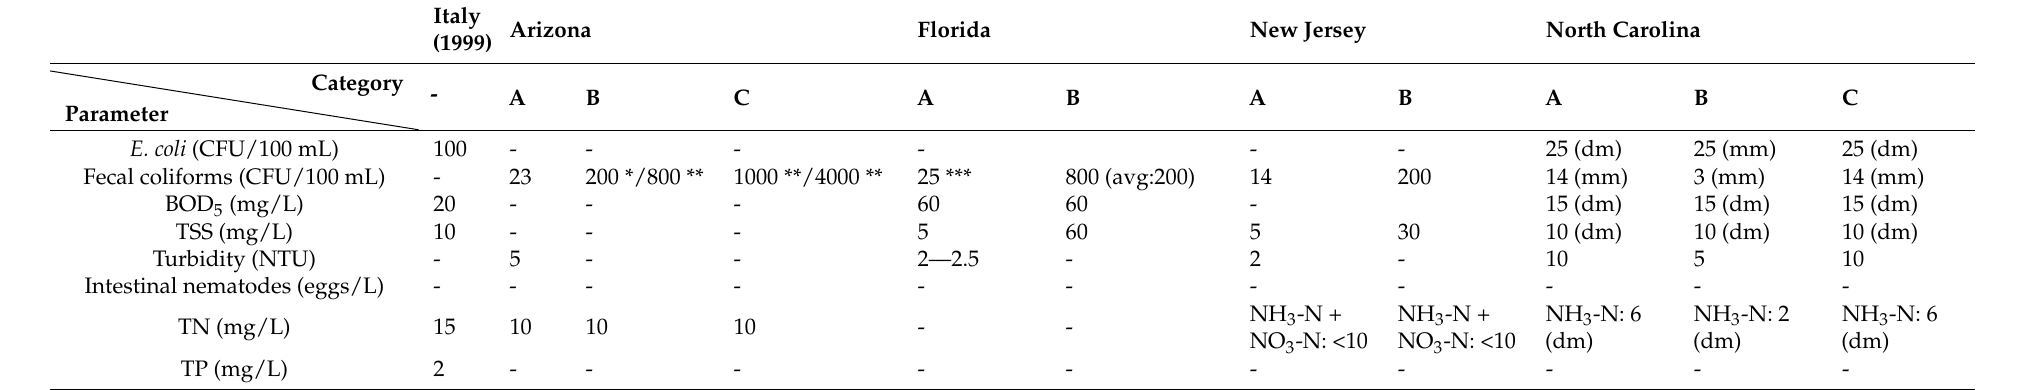
Table 3. Reclaimed water quality guidelines for agricultural reuse for Italy, Arizona, Florida, New Jersey, and North Carolina.